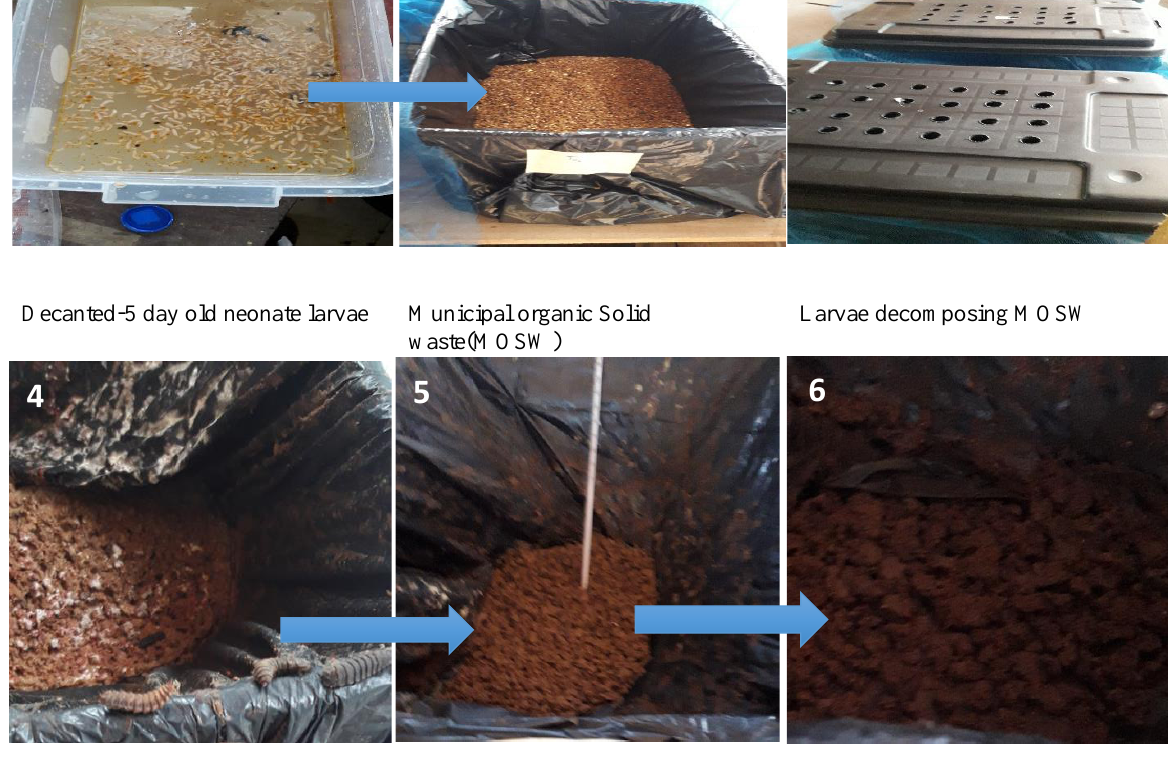
measured based on floatation and sedimentation method by (Schwartzbrod et al. 1989). Deionized water, Sie- mens was used in the preparation of diluted acid. For